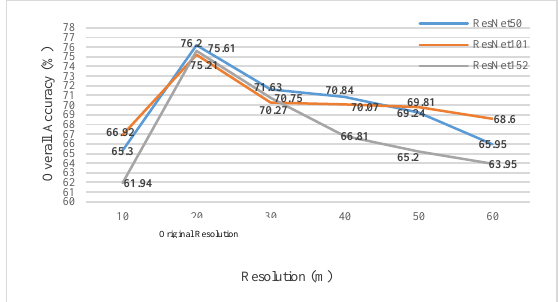
Figure 6. Average of overall accuracy obtained from the second experiment (with fine-tuning the parameters) on Sentinel-2 image.